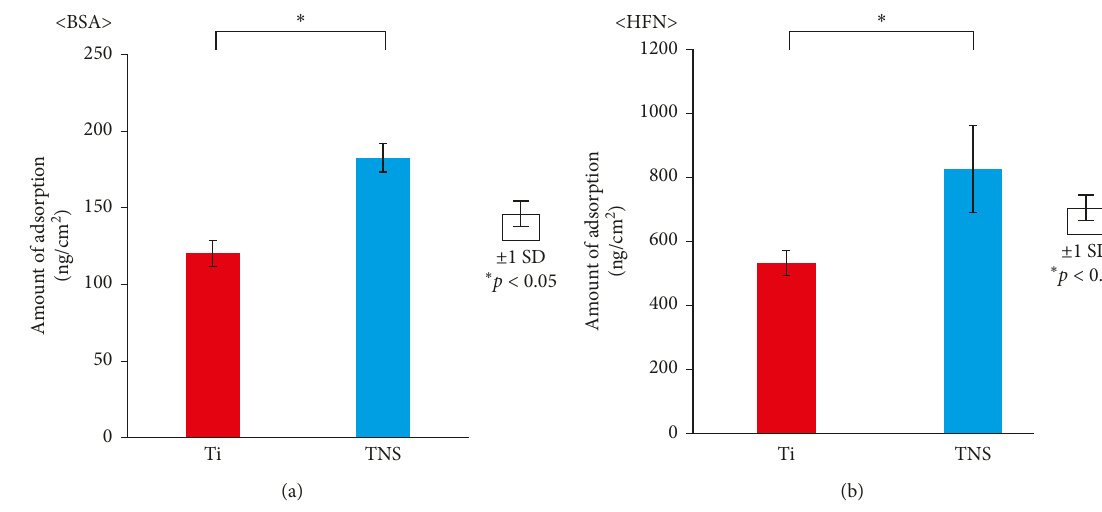
Figure 4: Adsorption of two proteins on Ti and TNS QCM sensors. (a) BSA. (b) HFN.